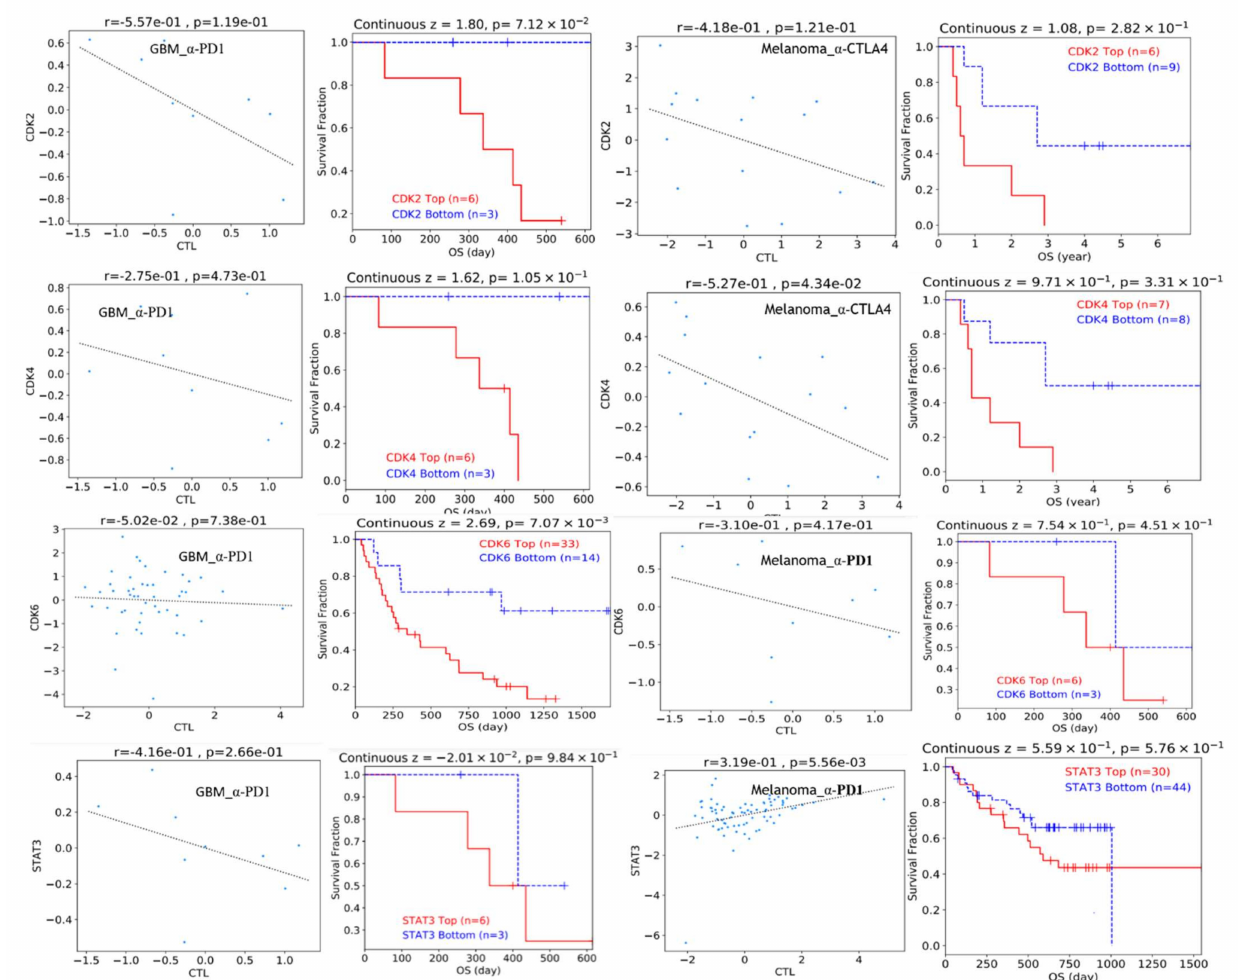
Figure 10. Effect of STAT3/CDK2/4/6 expression on therapy outcome in clinical studies of immune checkpoint blockade. Scatter plot of Spearman’s rank correlation and Kaplan Meier curve of the overall survival of cancer cohorts with up- expressed and down expressed STAT3/CDK2/4/6 status treated with anti-PD1 or anti-CTLA4